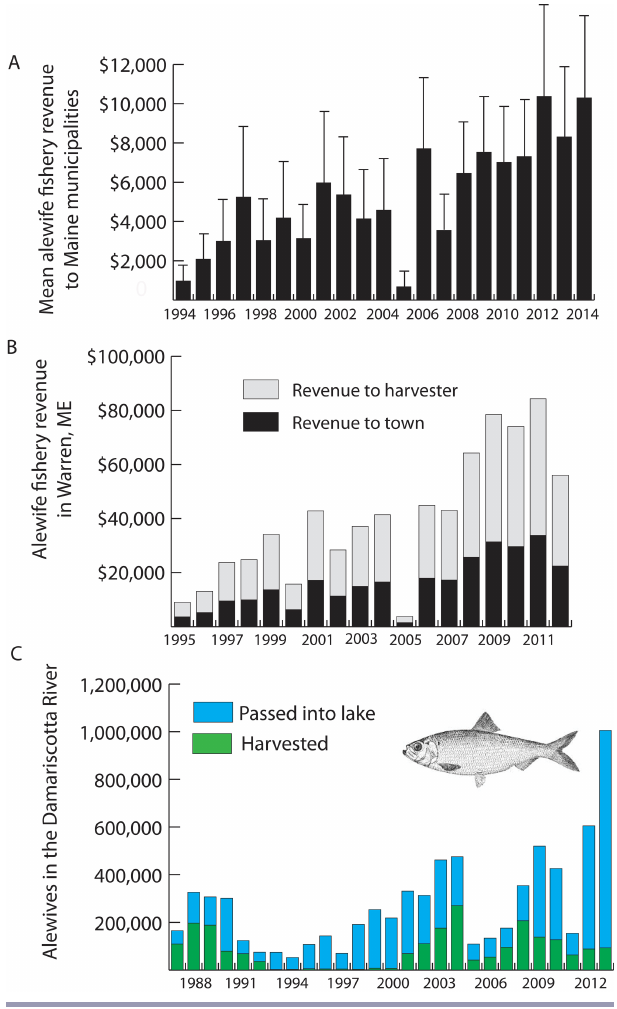
Fig. 3. Increases in alewife ( Alosa pseudoharengus ) populations and fisheries in Maine. (A) Mean revenue to Maine towns derived from leasing alewife harvesting rights, 1994–2014. Error bars represent standard error. (B) Revenue to harvesters and the municipality in a long-term alewife-harvesting town, Warren, Maine, 1995–2012. (C) Numbers of alewives harvested and passed upstream in the Damariscotta River,